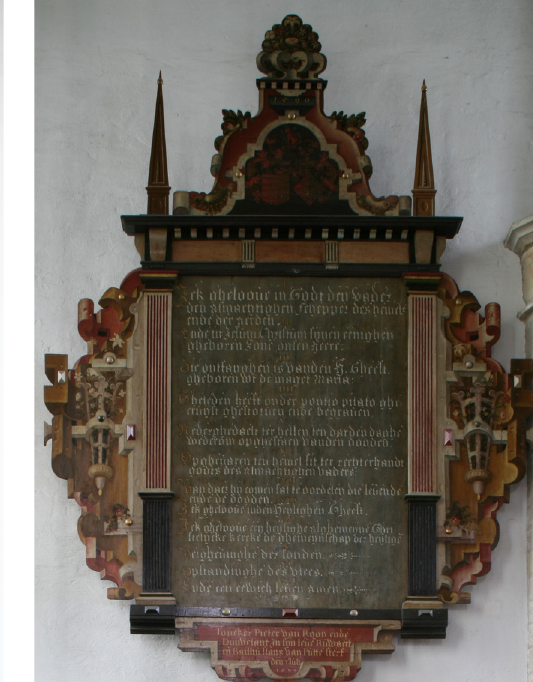
FIgure 3 Panel with the Creed, Geervliet, 1599, photo archive Regnerus